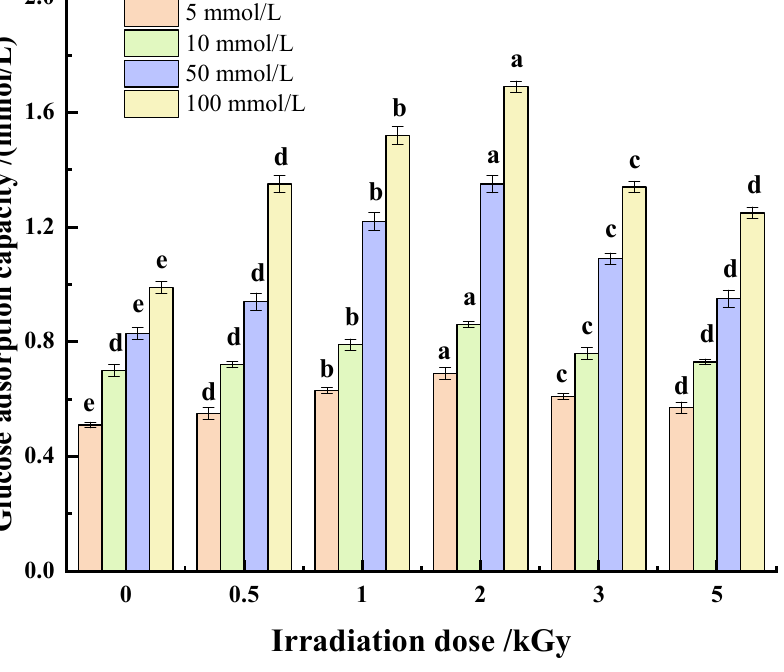
Figure 8. Effect of γ -irradiation on glucose adsorption of pea fiber. Note: Different small letters at the same concentration indicate significant differences in glucose adsorption capacity ( p < 0.05).